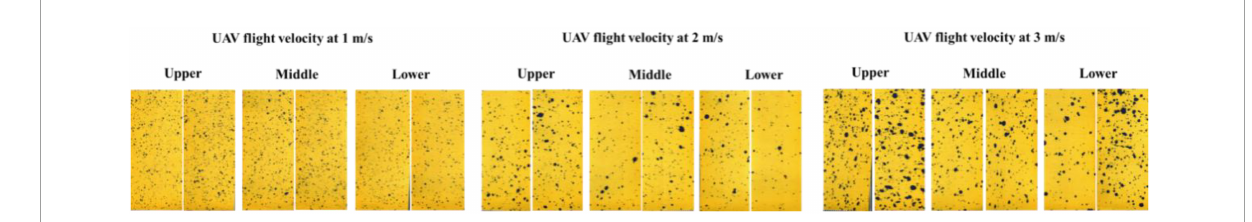
FIGURE4 Droplet distribution stains on water sensitive paper in canopy layers under different flight velocity of UAV.